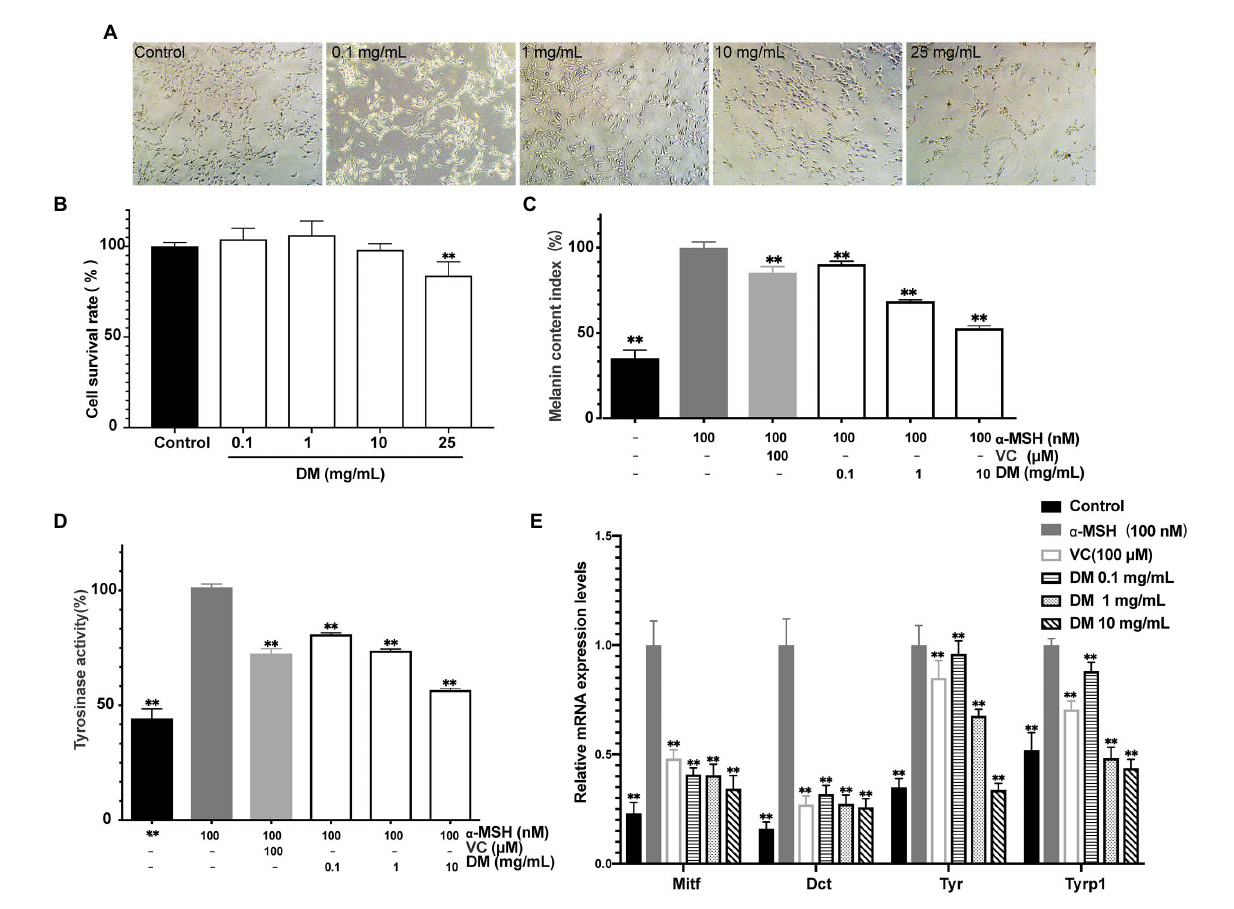
FIGURE 2 Whitening efficacy in vitro . (A) Light microscope image. (B) Effects of DM on B16 cell viability. (C) Effects of DM on melanin synthesis in B16 cells. (D) Effects of DM on TYR activity in B16 cells. (E) Effects of DM on expression of Mitf, Dct, Tyr, and Tyrp1 in B16 cells. The asterisk (**) indicated a significant difference ( p < 0.01) compared to the control of (B) . The asterisk (**) indicated a significant difference ( p < 0.01) compared to the 100 nM ɑ -MSH of (C–E)